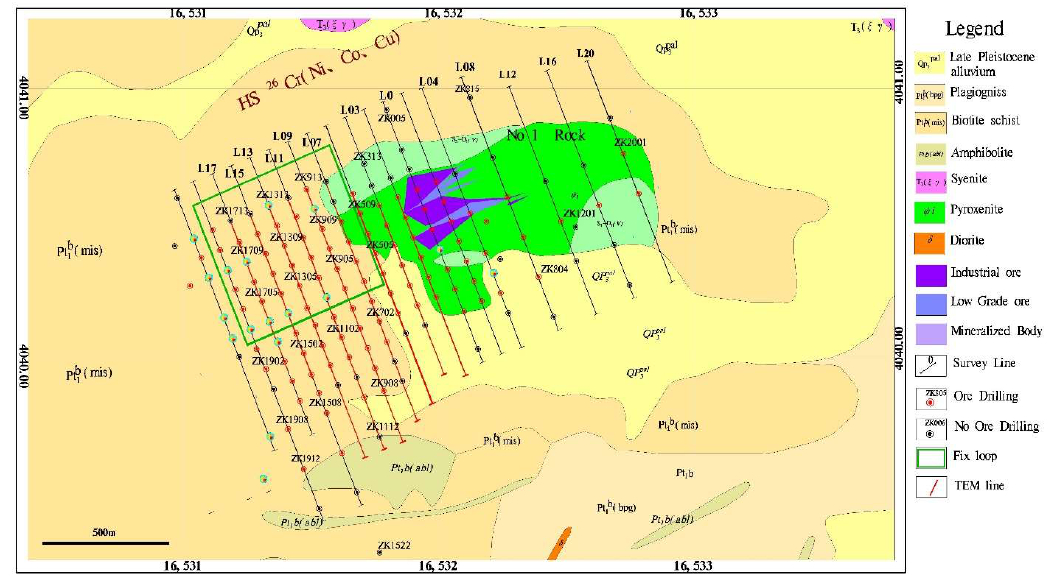
Figure 7. Geological map and TDEM test